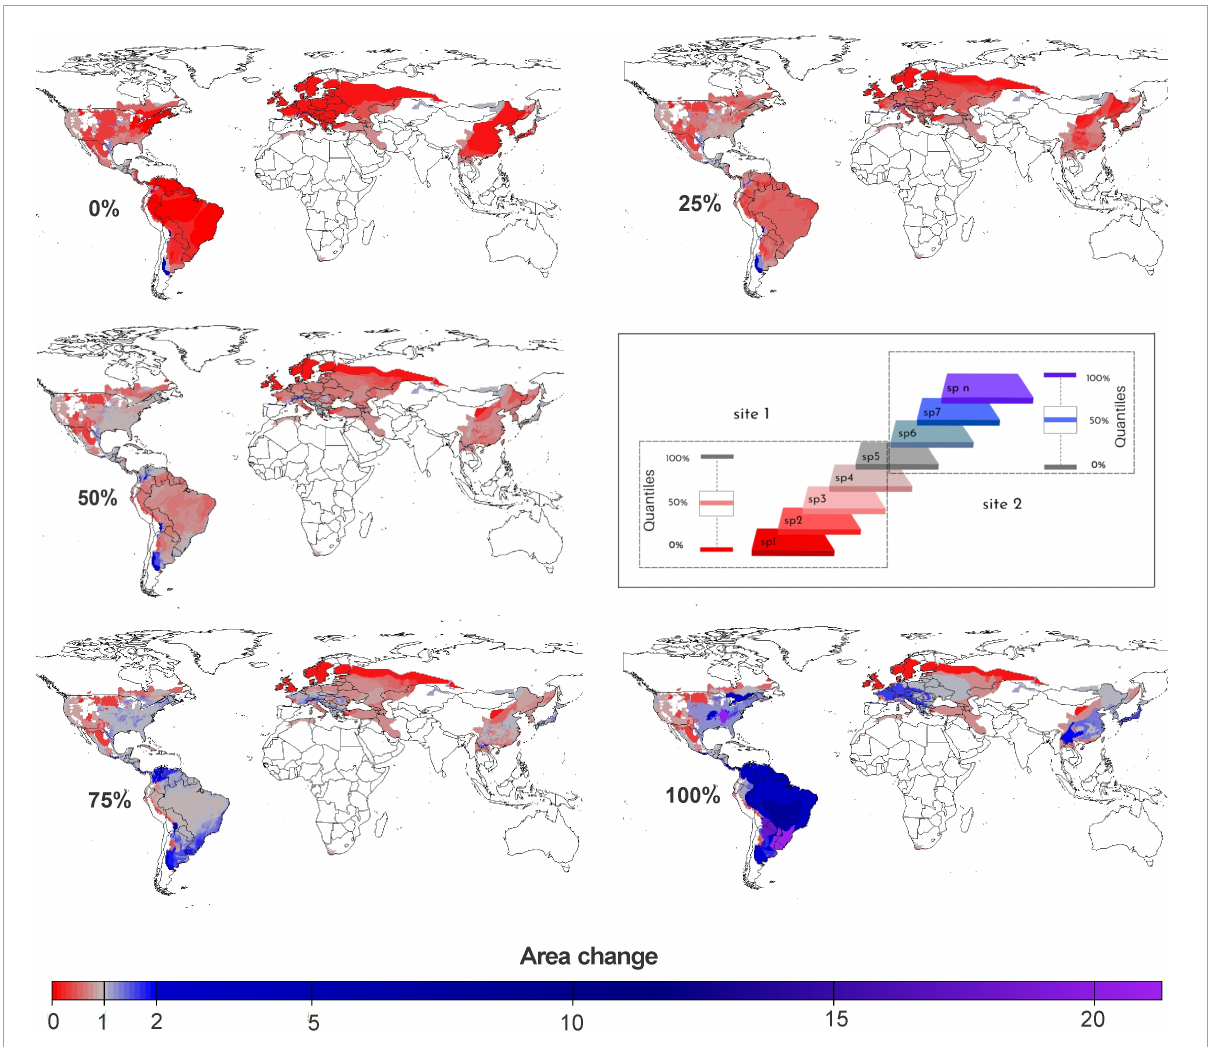
FIGURE5 Quartile maps showing the local variation in species responses to climate change. Red indicates losses in suitable areas, gray indicates no change, and blue to purple indicate gains in suitable areas. Quantiles were calculated for the responses of species occurring at each pixel (see graphical scheme of calculations in the center). At one extreme, the lower quantile (0%, minimum values) represents the lowest values of change (i.e., higher losses to smaller gains) among species occurring at each map pixel. The third quantile (50%, median) represents the central tendency among species. At the other extreme, the upper quantile (100%, maximum values) represents the highest values of change (i.e., smaller losses to higher gains of area) among